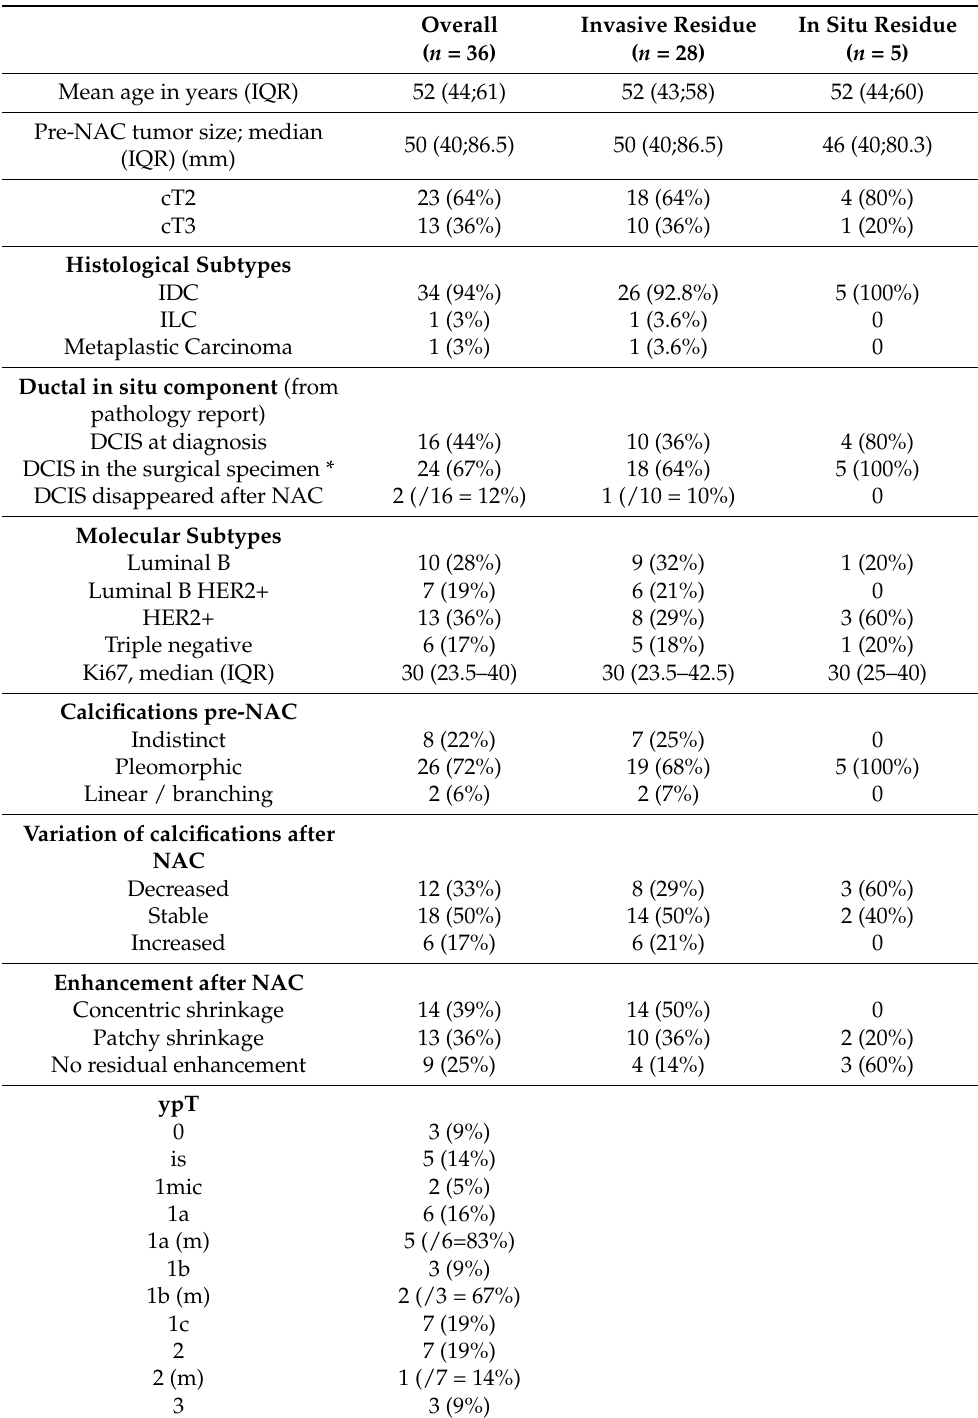
Table 1. Characteristics of the study population as a whole, only in patients with residual invasive tumor, and only in patients with in situ-only residual